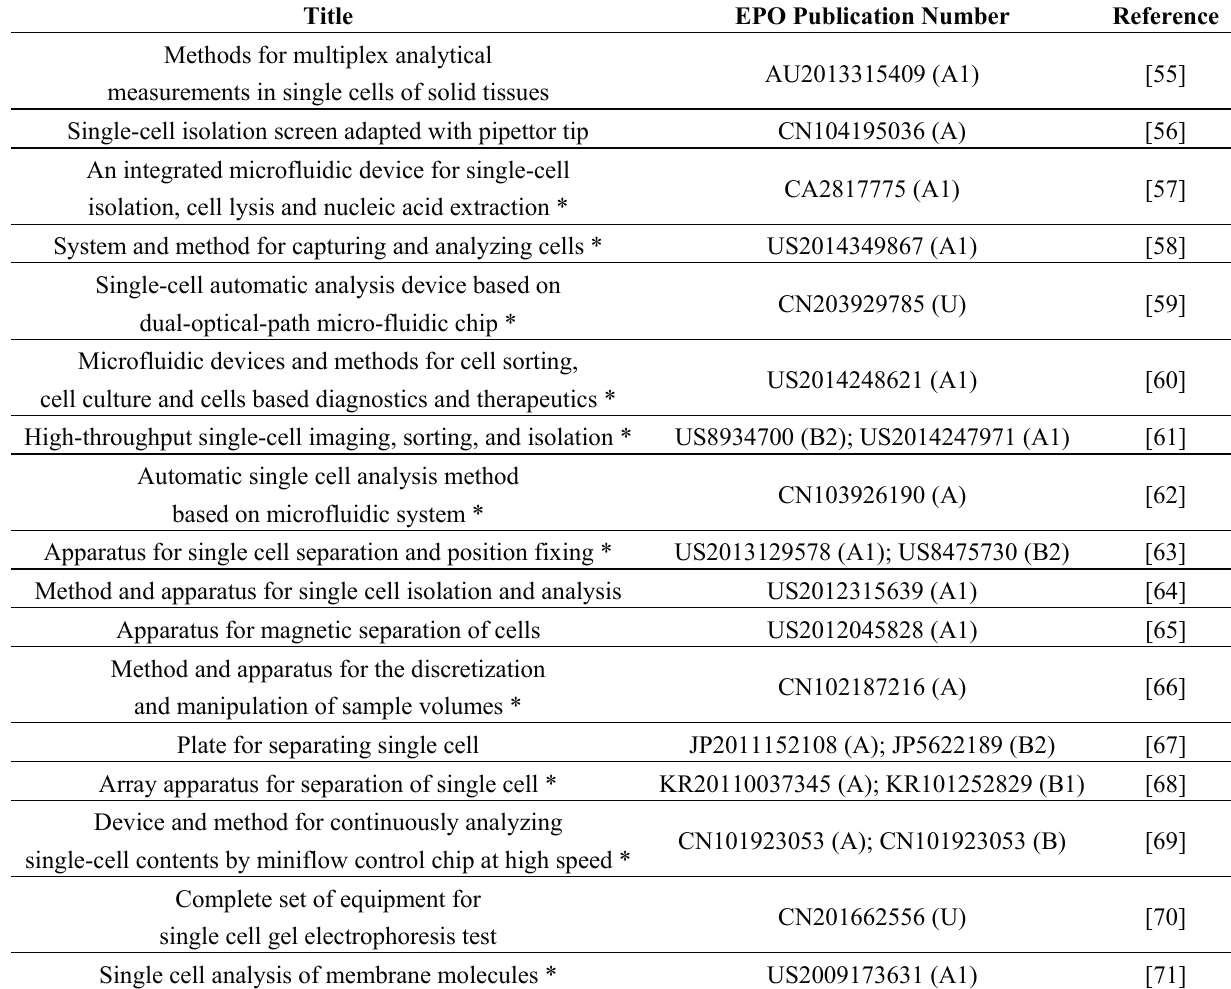
Table 2. Patents of single-cell isolation technologies identified in the worldwide database of the European Patent Office